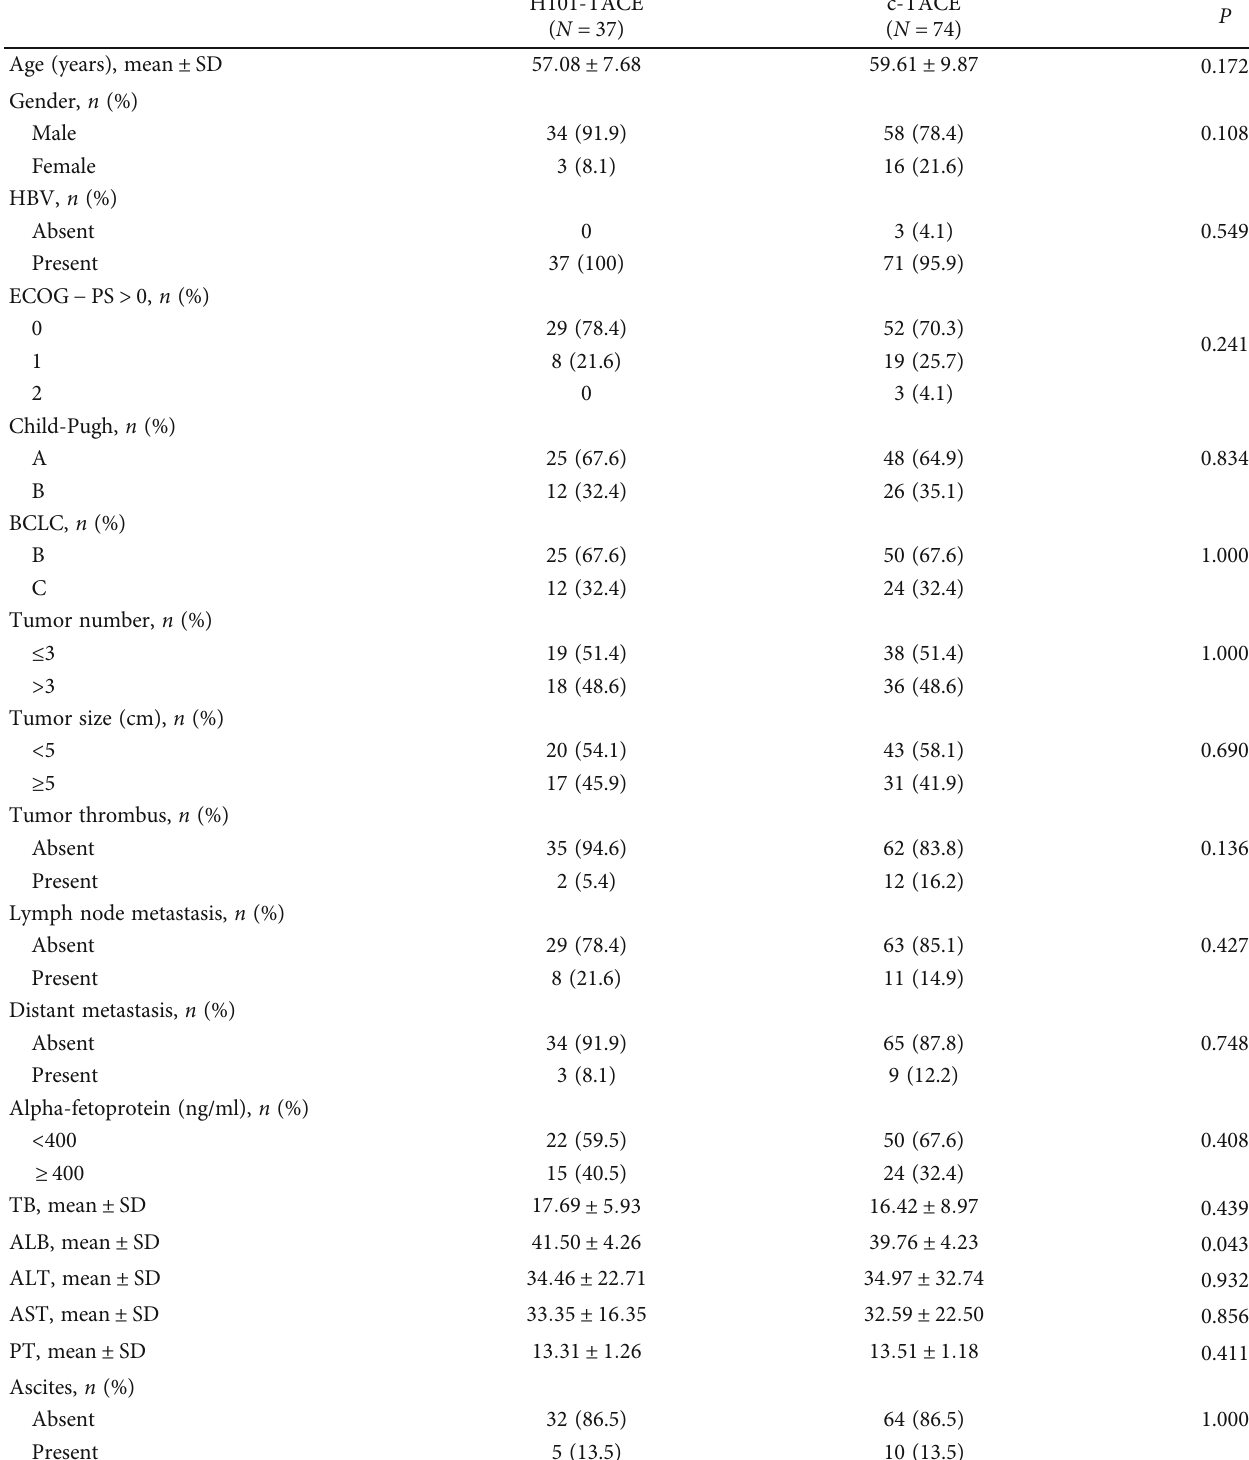
Table 1: Baseline characteristics of the study population before